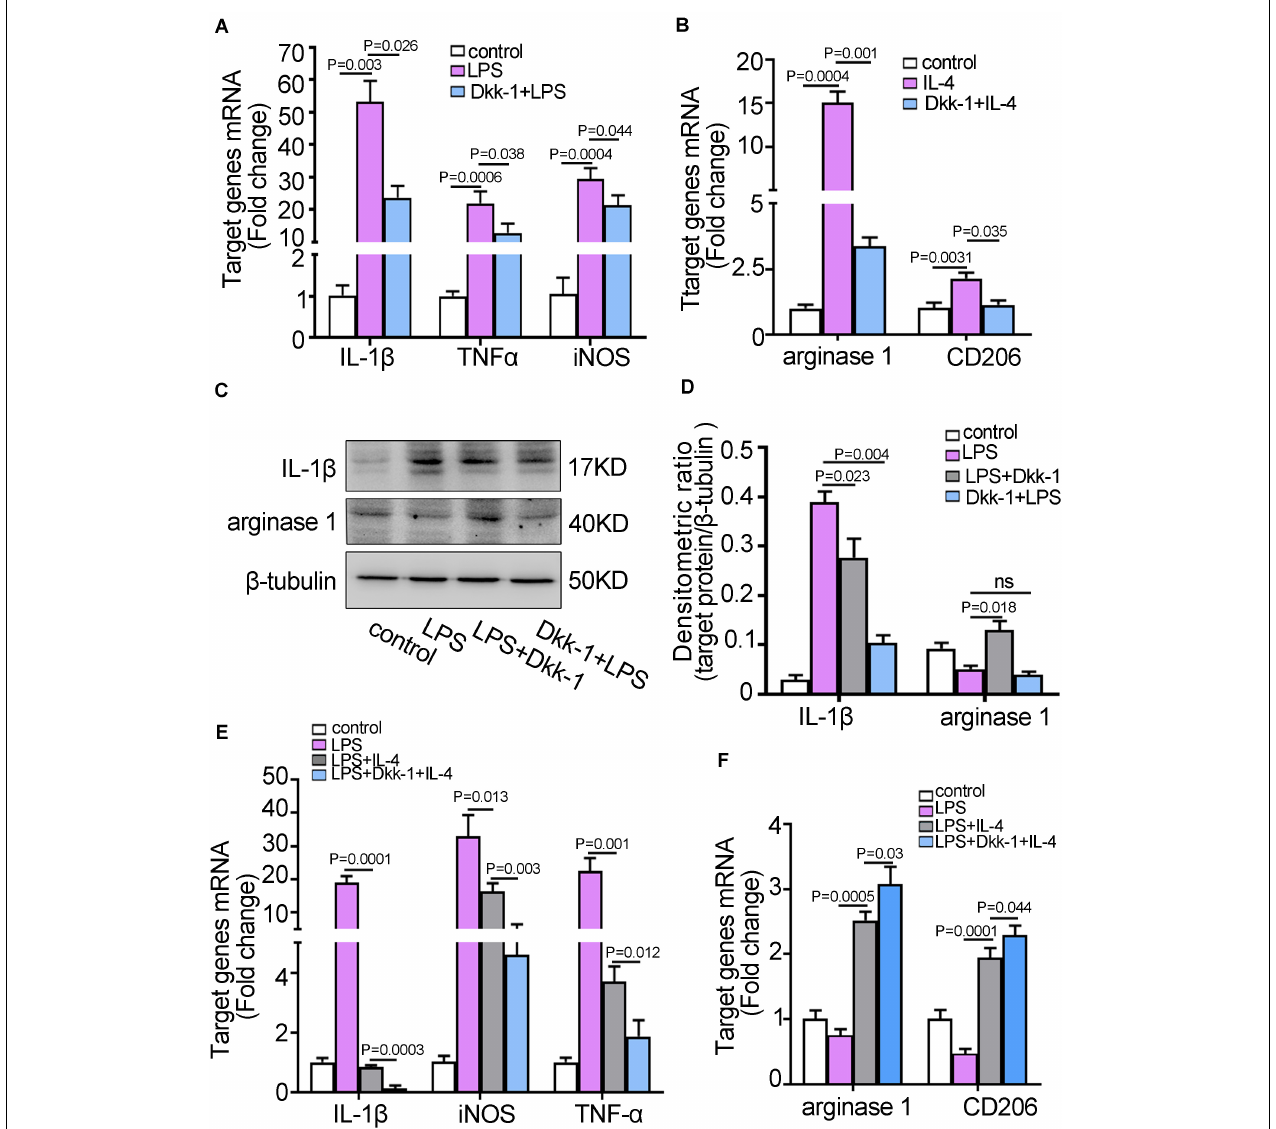
FIGURE 4 | Dkk-1 suppressed M1/M2 microglia activation and stimulates M1 to M2 phenotypic conversion of microglia. (A) The qRT-PCR analyses for M1 markers, IL-1 β , TNF- α , and iNOS, in BV2 cells pretreated with or without recombinant Dkk-1 proteins followed by LPS stimulation. The BV2 cells alone were as the control. (B) The qRT-PCR analyses for M2 markers, arginase-1 and CD206, in BV2 cells pretreated with or without recombinant Dkk-1 protein followed by IL-4 stimulation. The BV2 cells alone were as the controls. (C) The BV2 cells were stimulated with LPS prior to treatment with recombinant Dkk-1 proteins. Alternatively, The BV2 cells were pretreated with recombinant Dkk-1 proteins following exposure to LPS stimulation. The analyses of western blot for IL-1 β and arginase-1 in the indicated BV2 microglia cells were shown. (D) The quantitative analysis of western blots for IL-1 β and arginase-1 were shown. The histogram represented the average levels of target proteins measured by densitometric values using Image J software, normalized to the levels of β -tubulin. The results were presented as mean ± SD of three independent experiments. (E,F) The BV2 cells were pretreated with LPS to be M1 phenotypic microglia. Treatment of LPS-stimulated BV2 cells with only IL-4, or combination with recombinant Dkk-1 protein and IL-4. After 24 h, the levels of M1 markers (E) and M2 markers (F) were examined by qRT-PCR. All results were presented as mean ± SD of three independent